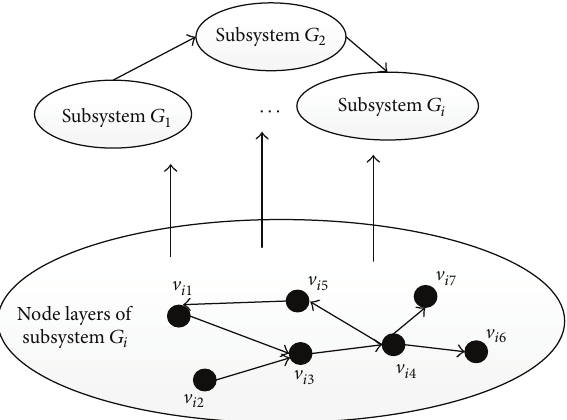
Figure 1: Model of system reliability consisted of independent